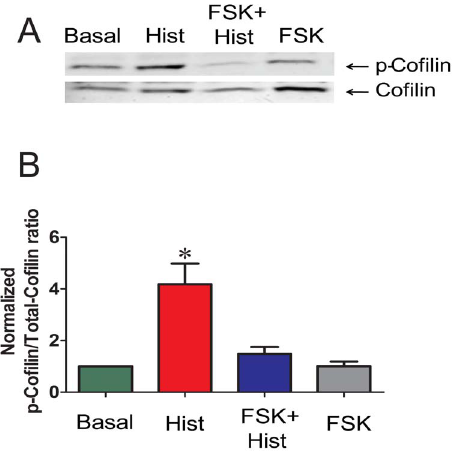
Figure 7. Preincubation with forskolin induces phosphoryla- tion of VASP. Conditions are the same as described in Figure 3. Proteins were extracted and separated on SDS polyacrylamide gels. Phosphorylation of VASP causes mobility shift in the SDS gel and p- and np- VASP forms were detected by western blotting using VASP antibody that recognizes both forms. Panel A: Representative western blot of p- and np-VASP. Panel B: Cumulative data representing the relative amounts of p-VASP/total VASP and then normalized to the basal. Quantitative values were obtained when the phosphorylated and non-phosphorylated bands were quantitated densitometrically. n=4, p , 0.05. *significant compared to histamine.